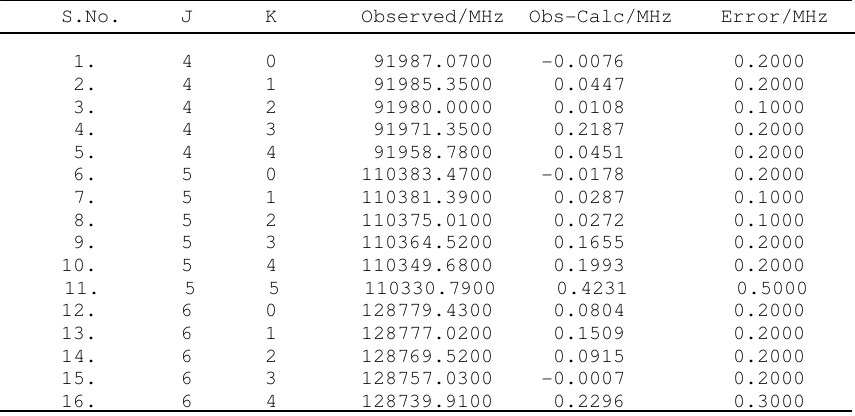
Table 1 . Results of refinement of observed frequencies for CH